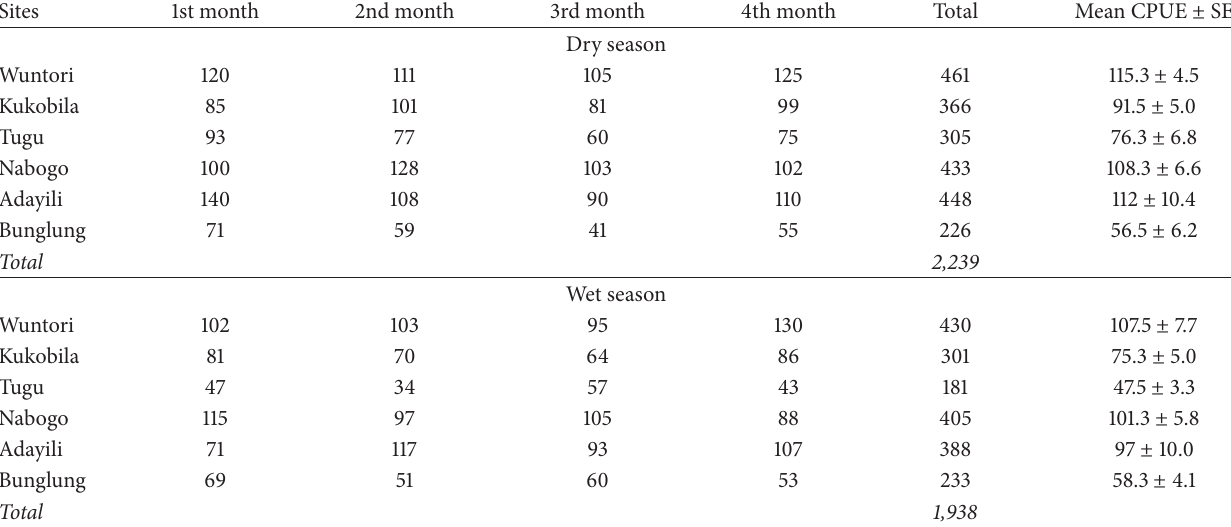
Table 1: Mean monthly catch per unit effort per net (CPUE) during the dry (November–February) and wet (July–October) seasons, in the six